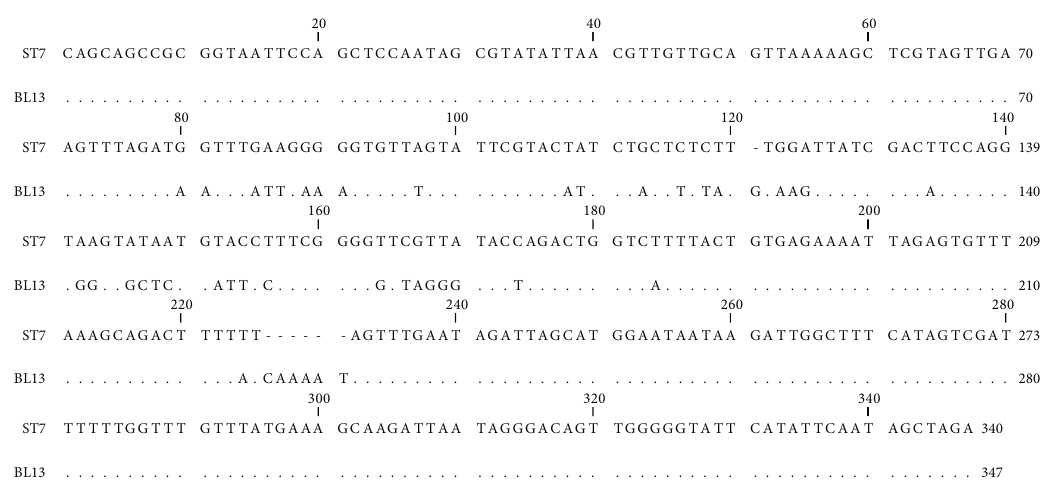
Figure 5: Alignment nucleotides of accession number MH049535 (BL13) with the ST7